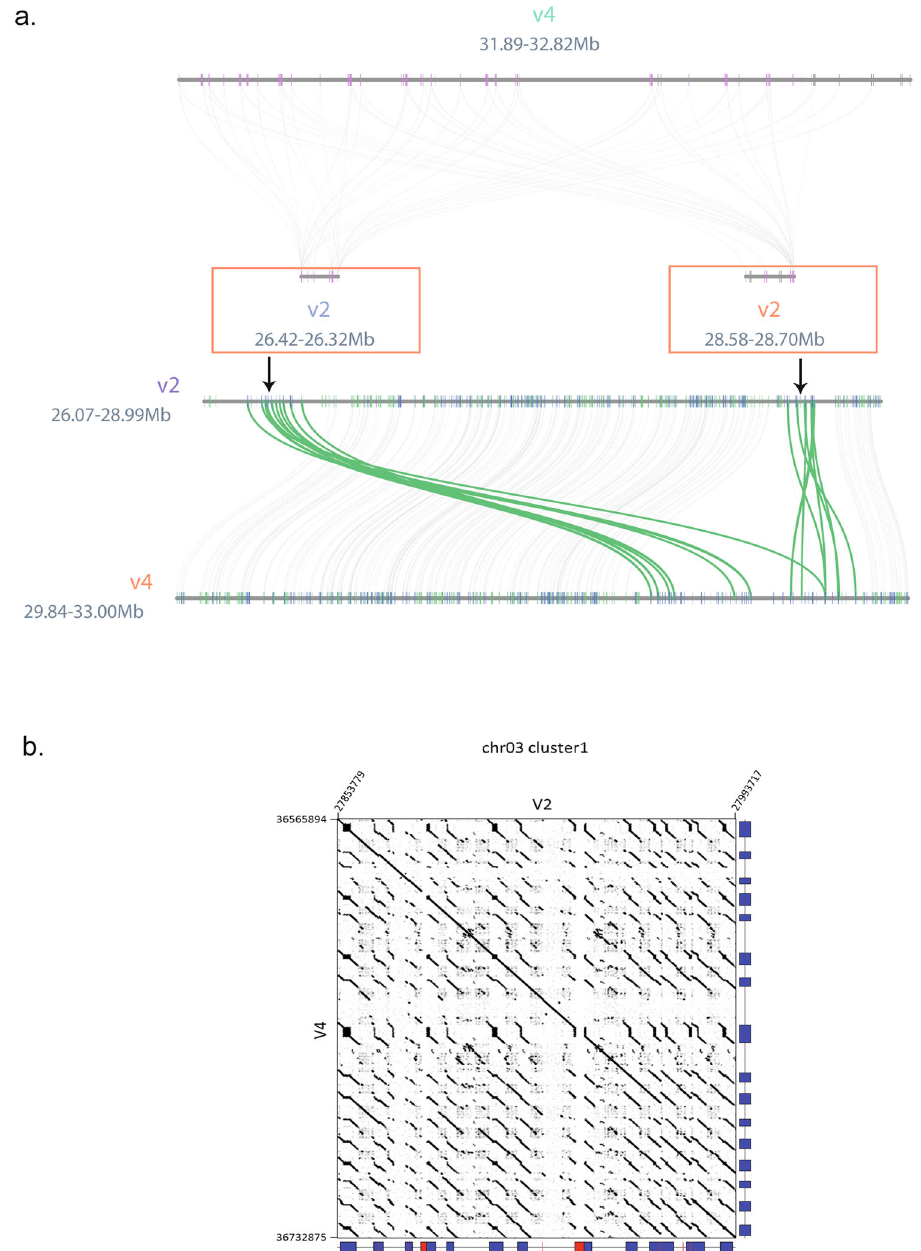
Fig. 4 Comparison of tandemly duplicated gene regions in the V2 and V4 assemblies. a Synteny visualization of gene clusters of the terpene synthase family. The cluster is located between 31.89 and 32.82 Mbp on the V4 (chromosome 7). Gene synteny relationships are colored in green, and genes are colored according to their orientation (blue if forward and green otherwise). b Comparison of the structure of a NLR cluster on chromosome 3. The predicted NLR loci for each version are represented by blue boxes on the x - and y -axis of the dot plots. Red boxes represent regions bearing undetermined nucleotides. Region coordinates are also